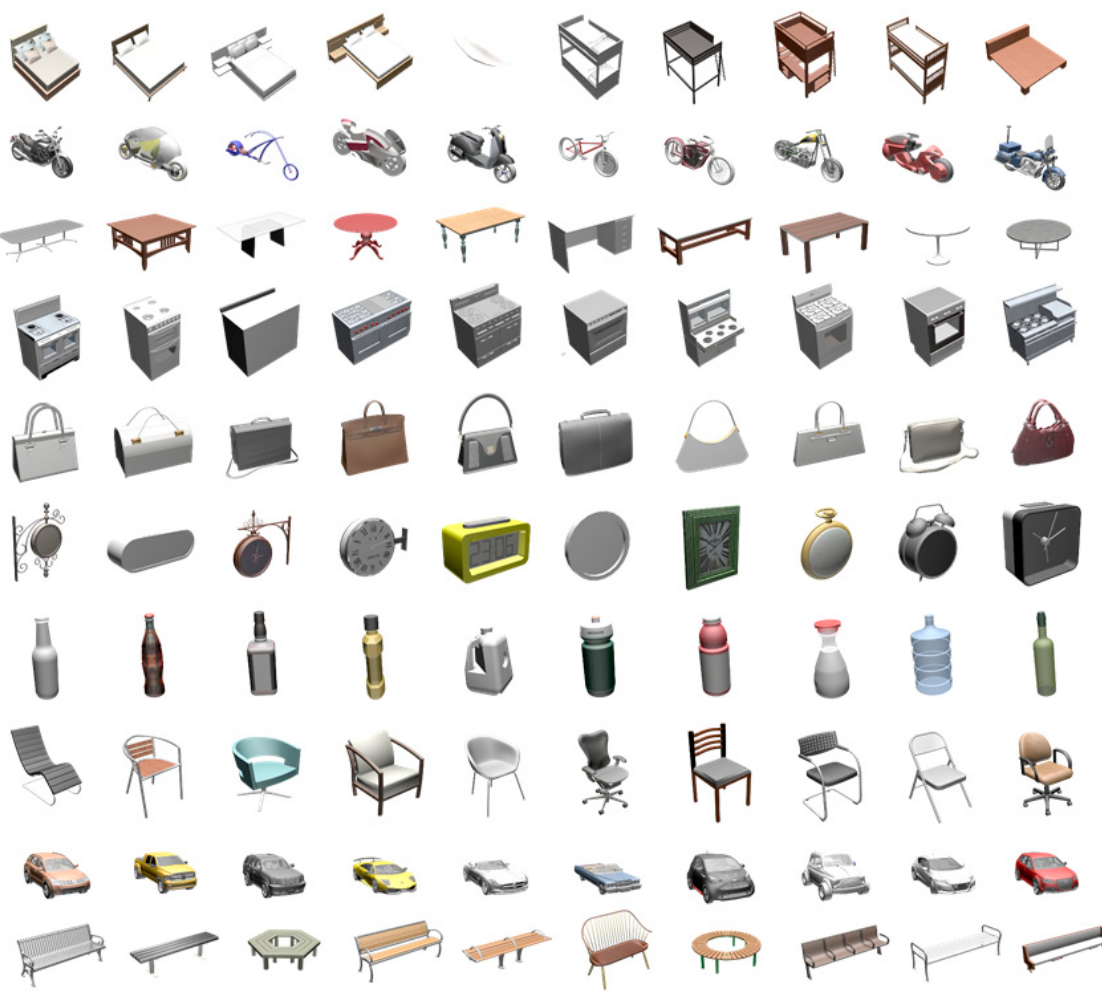
Figure 6. Ten ShapeNetCore categories and candidate CAD models used in the experiment. From the top, Bed, Motobike, Table, Oven, Bag, Clock, Bottle, Chair, Car , and Bench (The italic type means the test object’s name).